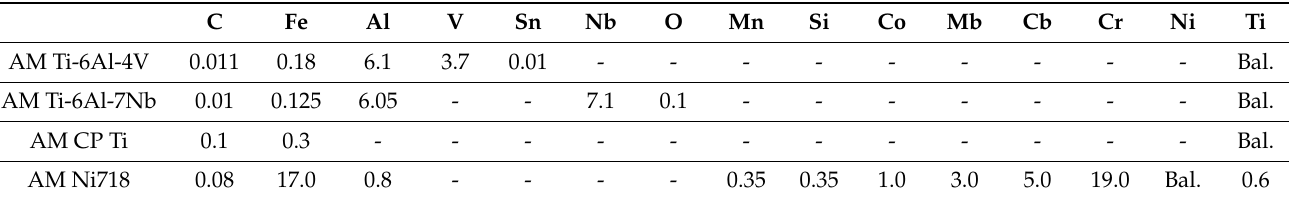
Table 1. Material composition of the AM alloys